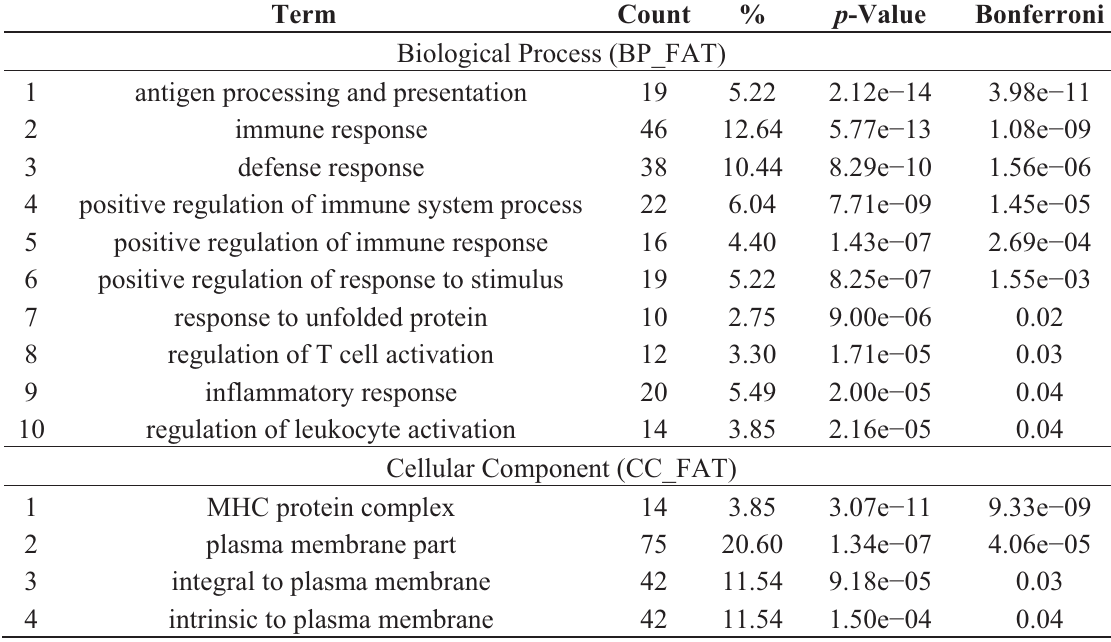
Table 5. GO term-based annotation of T1D genes harboring Alu elements. The enriched GO terms are followed by the number of genes having the enriched term (count), the percentage of genes with the enriched term (%), p -values based on EASE scores, and Bonferroni correction p